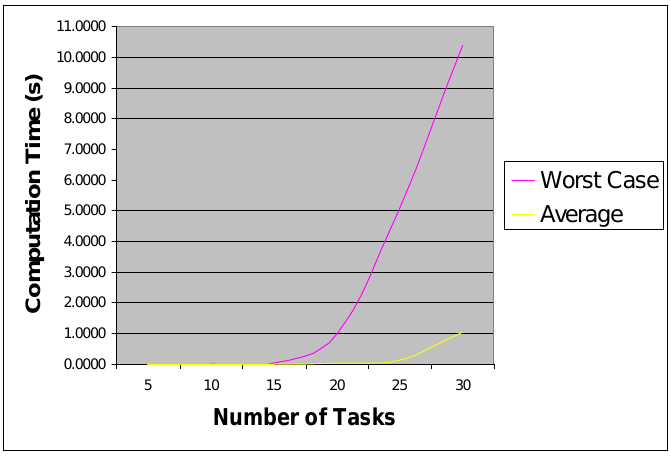
Figure 12. MULTIFIT running